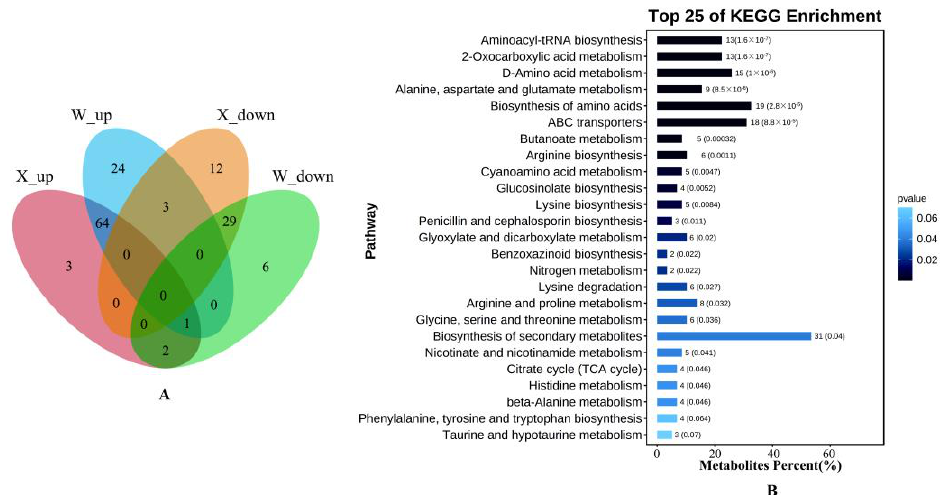
Figure 4. ( A ) Venn diagrams of differential metabolites up-regulated by drought-tolerant geno- type (X) and drought-sensitive genotype (W); ( B ): KEGG enrichment pathway map of DMs in 8 comparison groups.